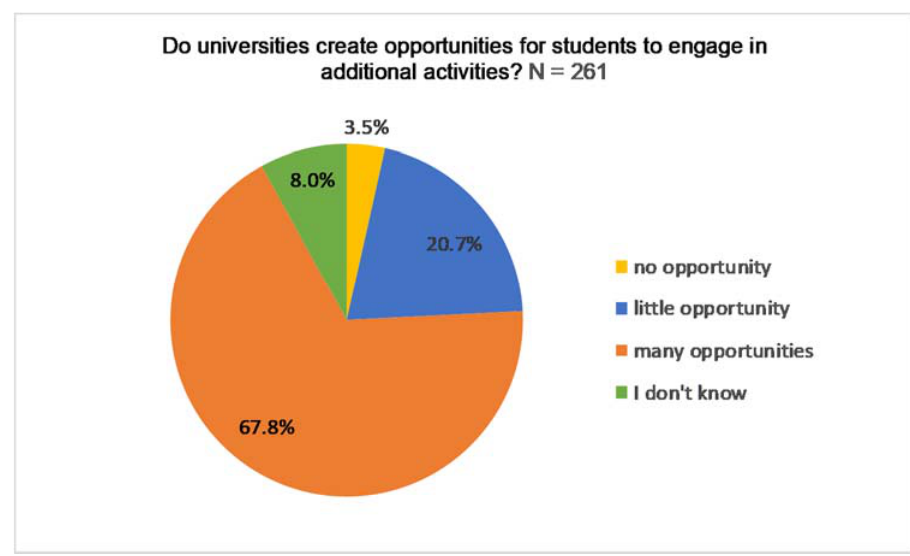
Figure 1. Student perceptions of extracurricular opportunities created by universities.